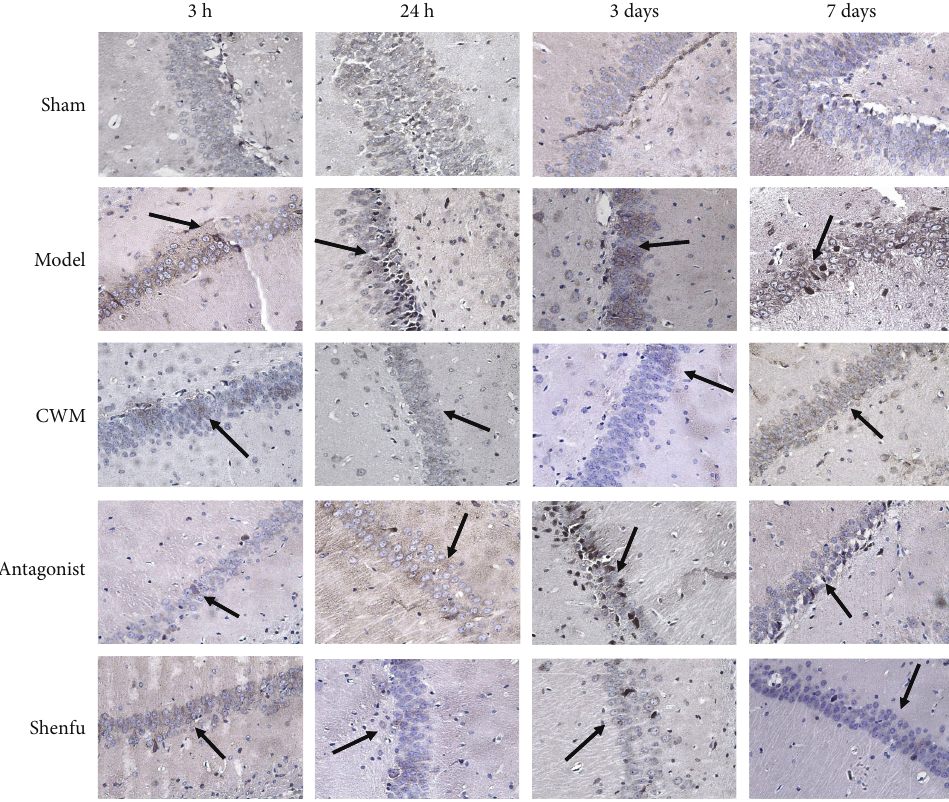
Figure 5: Immunohistochemical detection of Nogo receptor positive cells indicated by black arrows in hippocampal tissues of each